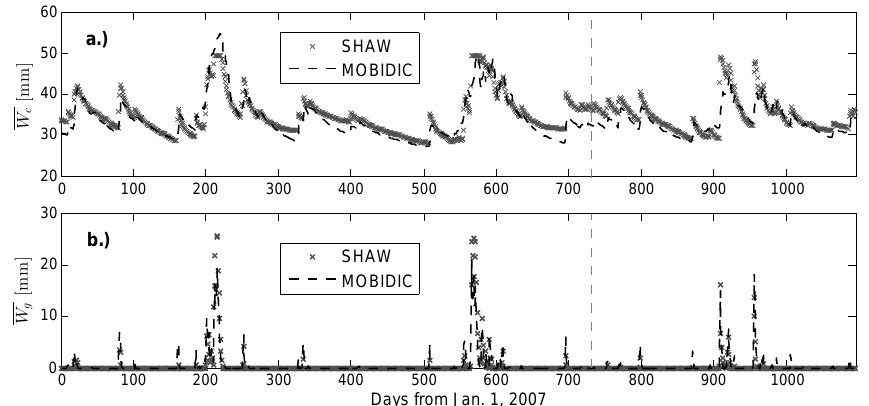
Figure 4. The SHAW- and MOBIDIC-simulated equivalent depth [cm] of water stored in the soil (a) capillary reservoir and (b) gravity reservoir for the top 50cm of Site 1.